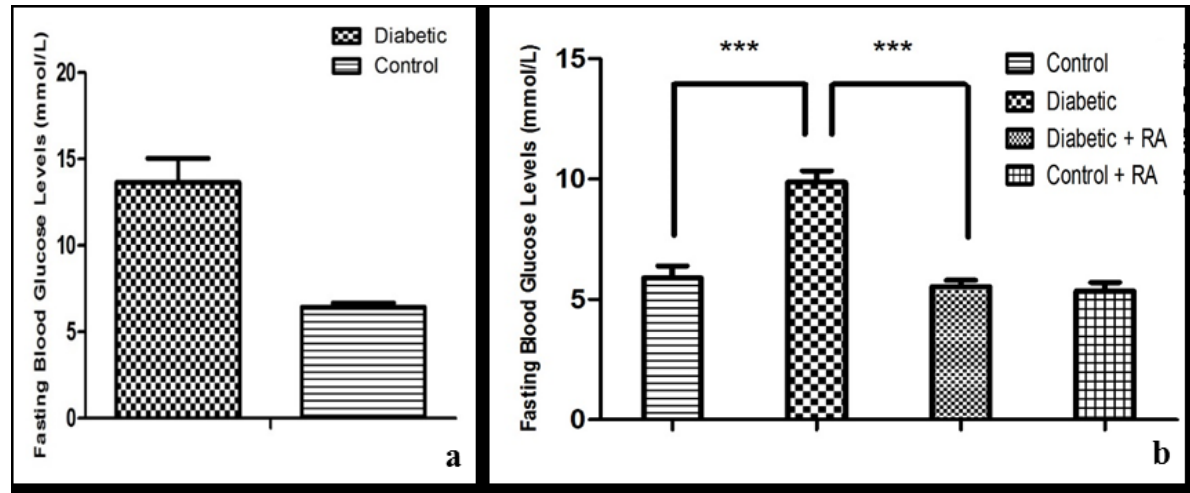
FIGURE 2 - Average Fasting Blood Glucose (FBG) Levels (mmol/L): (a) Average FBG (mmol/L) of control and diabetic groups which were kept on HFD from 4 to 9 weeks of age and injected with STZ (100 mg/kg ip) at 6 and 9 weeks of age. (b) Average FBG (mmol/L) after rosmarinic acid treatment of experimental animal groups (diabetic, control, diabetic + RA and RA only) after 7 days treatment (4 mg/kg RA ip).